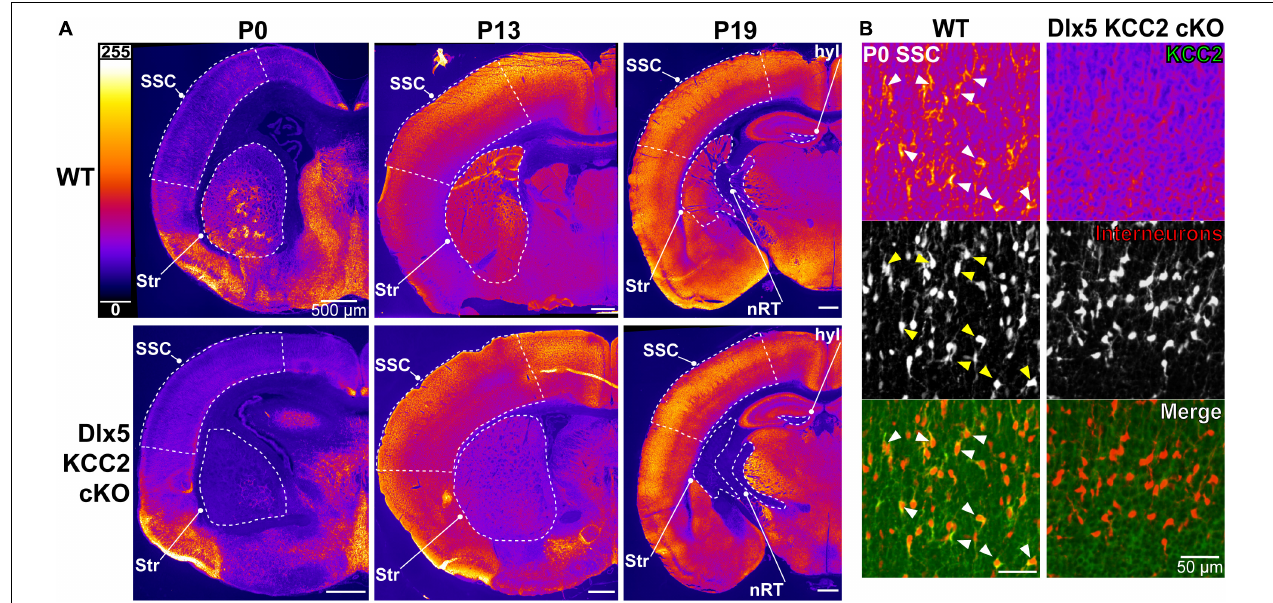
FIGURE 2 | Loss of KCC2 expression in INs of Dlx5 KCC2 cKO. (A) KCC2 expression in WT (top row) and Dlx5 KCC2 cKO (bottom row) cortical hemisections at P0, P13, and P19. Note lack of KCC2 immunoreactivity in somatosensory cortex (SSC) of Dlx5 KCC2 cKO at P0, but not at later ages. Loss of immunoreactivity persists in striatum (Str), hippocampal hilus (hyl), and reticular nucleus of thalamus (nRT). Regions of interest are outlined by a dashed white line. (B) Close-up images showing loss of plasmalemmal KCC2 immunoreactivity in INs marked by cre tdTomato reporter (KCC2 green, INs red). Arrows point out several examples of KCC2-expressing INs in